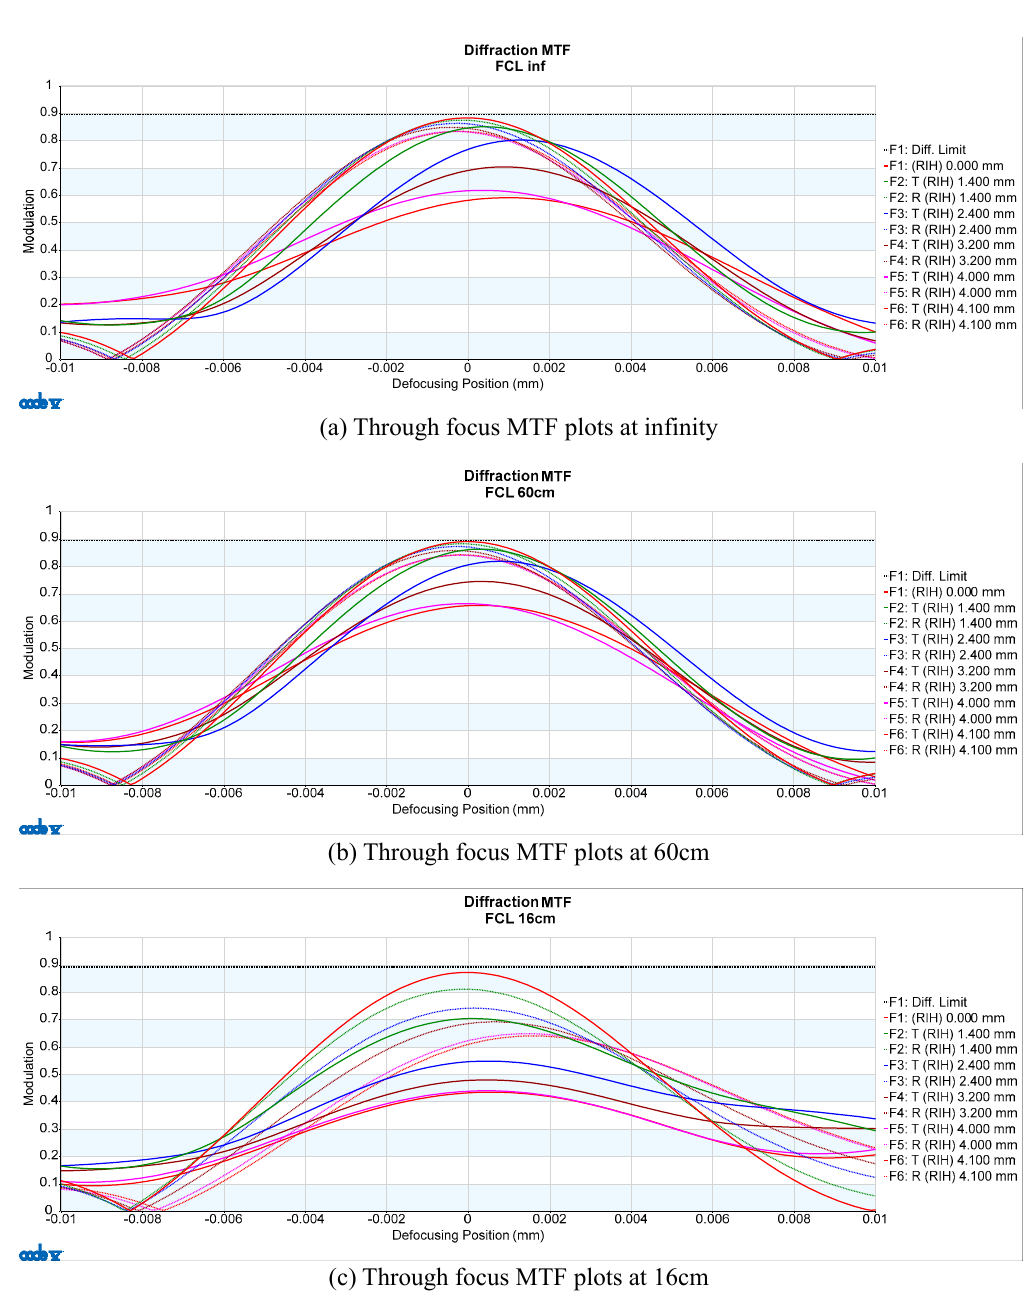
Figure 7. Modulation transfer function (MTF) graph of the aberration-balanced collimator.